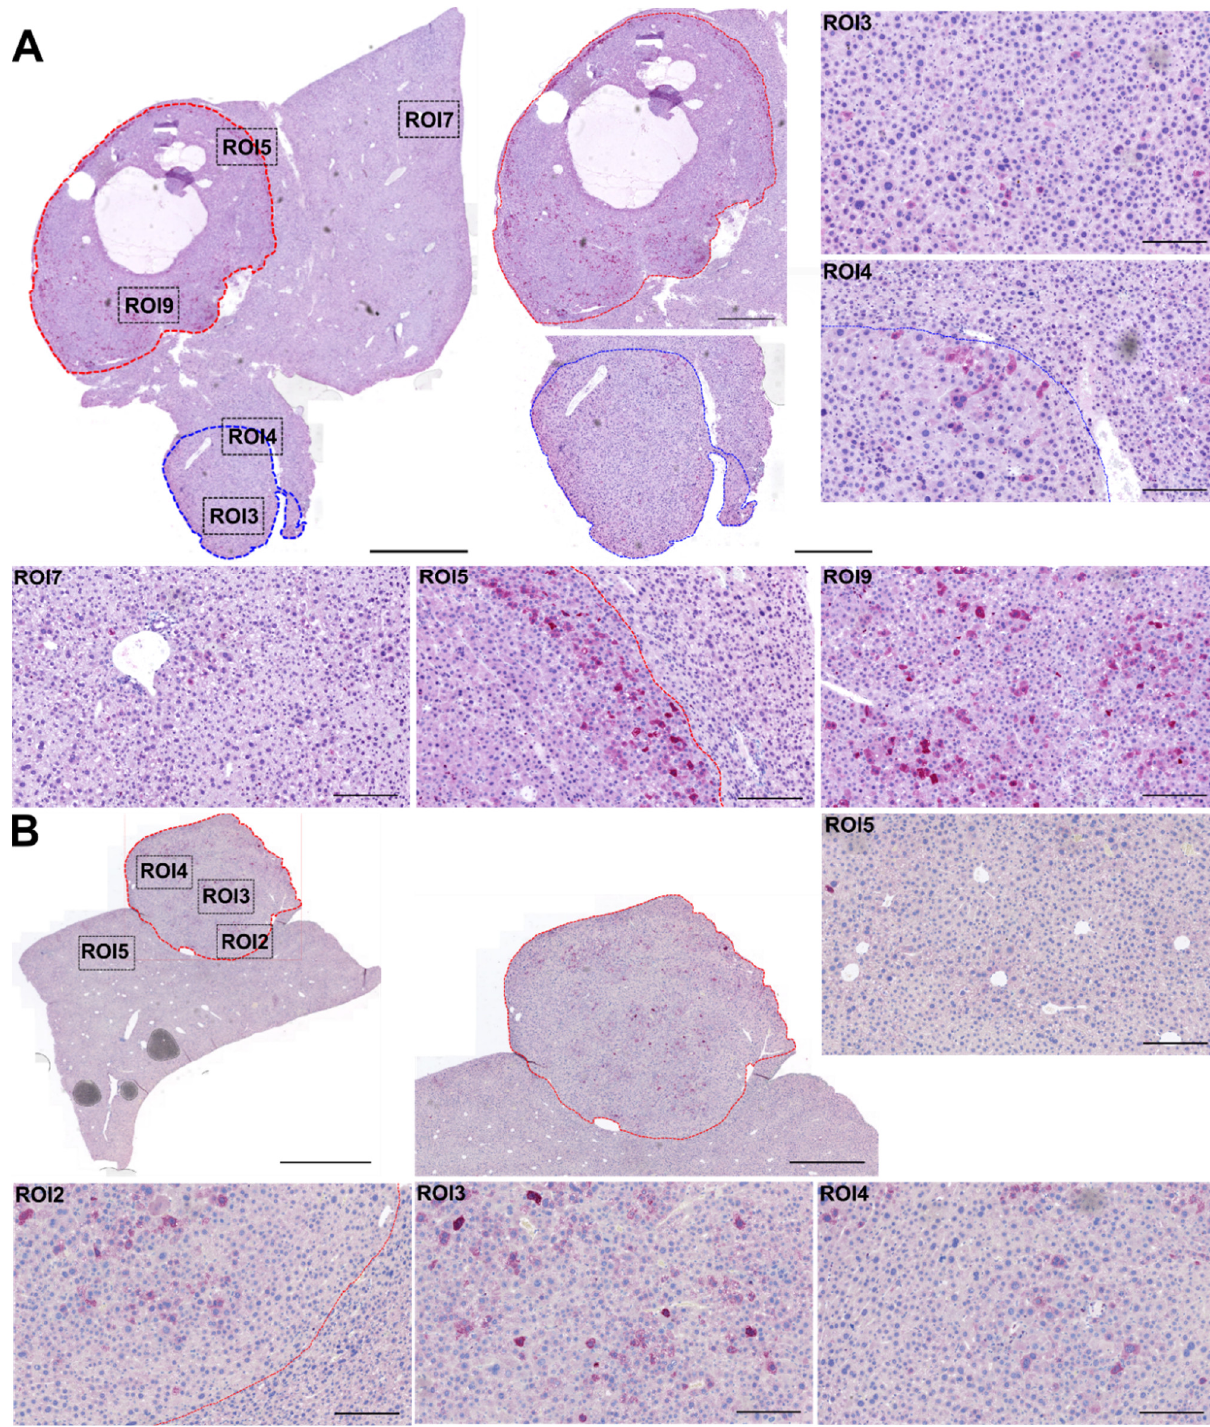
Figure 3. Immunohistochemical analysis of transgene (eGFP) expression in liver and HCC of TGFα/c-myc HCC mice. Tumor-bearing mice received scAAV2.SFFV.Fluc and scAAV2.CMV.eGFP. Vector dose: 2 × 10 11 particles per vector per animal. Representative histological images of tumor-bearing liver sections of ( A ) Animal 2 and ( B ) Animal 8, 84 h post scAAV2.CMV.eGFP administration, which equals 96 h of scAAV2.SFFV.Fluc presence. eGFP-positive cells (in red) in the liver and HCC were visualized by immunostaining using Abcam anti-eGFP antibody. ROI = region of interest. Scale bars: total section in ( A ): 1 mm, in ( B ): 2 mm; magnified tumor lesions ( B ) (red frame): 1 mm; ROIs in ( A , B ) 0.2 mm. N = 8 animals .